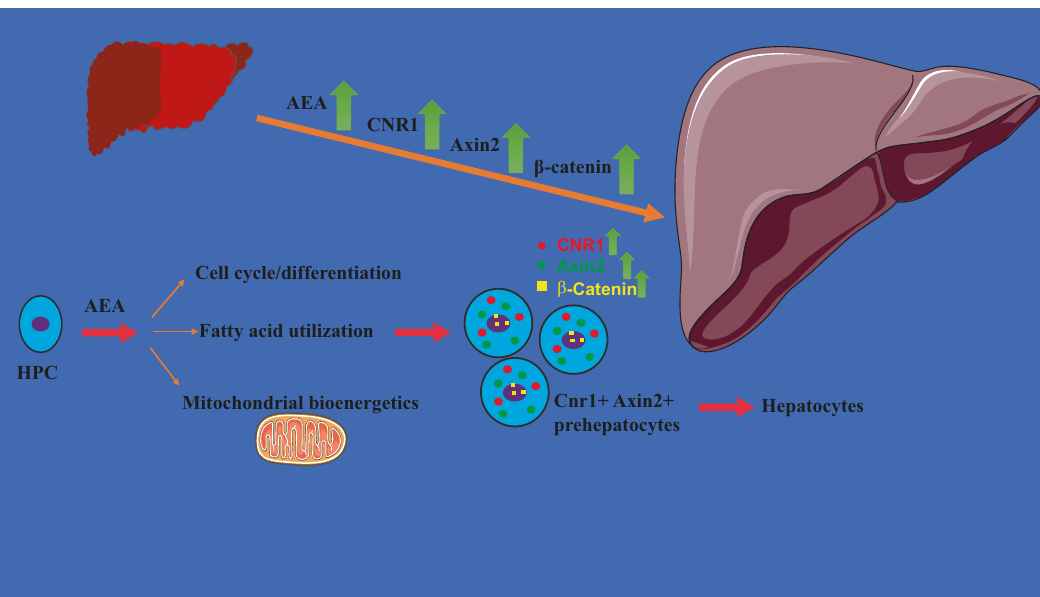
Fig. 7 Schematic representation of similar molecular events in liver regeneration after PHx and AEA-induced cell proliferation and differentiation of hepatic progenitor cells. AEA promotes the nuclear localization of the transcription factor β -catenin, with subsequent induction of its downstream targets leading to cell cycling and differentiation. AEA also promotes mitochondrial energetics in HPCs when amino acids and glucose are readily available as substrates, but AEA inhibits it when the cells rely primarily on fatty acid oxidation. The fi